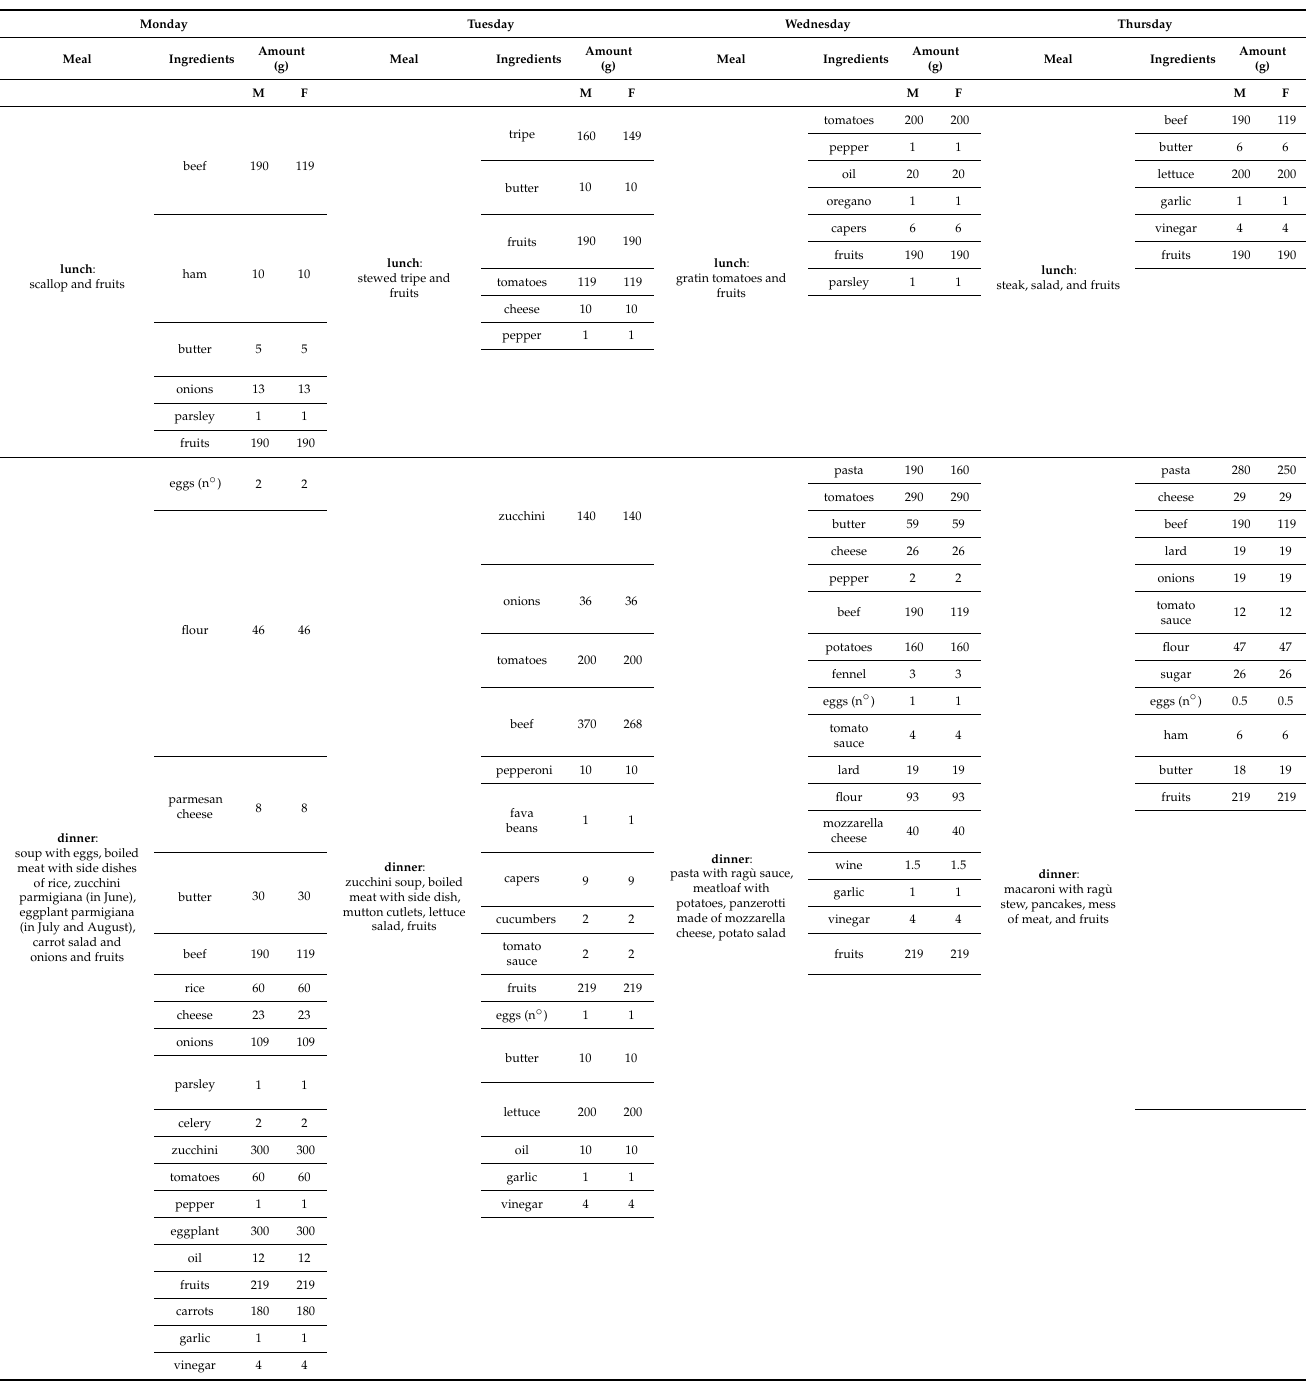
Table 7. Individual meals for 1st and 2nd class patients at lunch and dinner. Months: June, July and August (1)